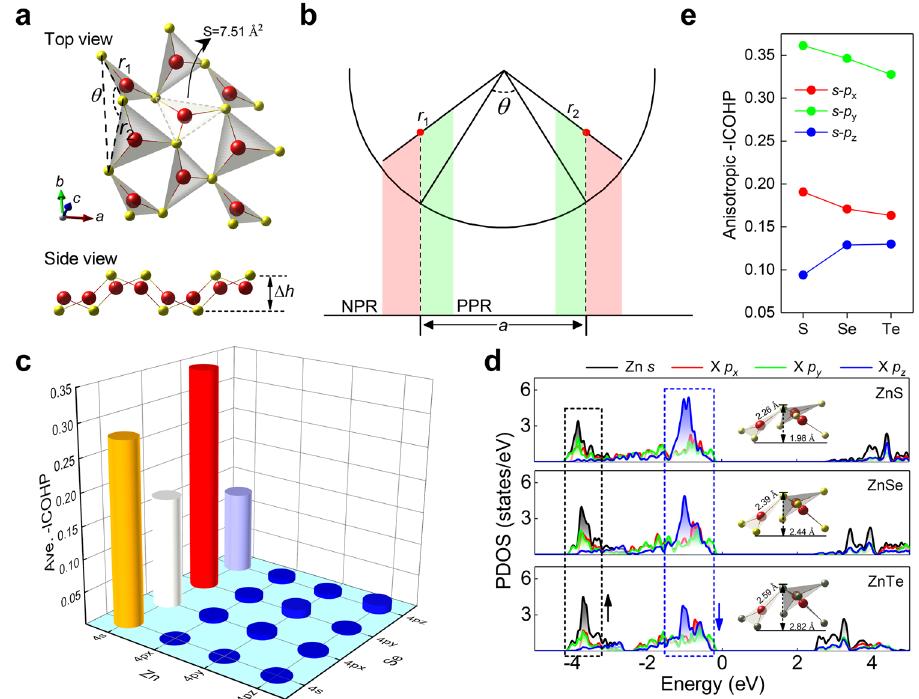
Fig. 5 Origin of the NPR for wz monolayers. a Top and side view for wz monolayer, in which we denote three structural parameters, i.e., the sides and angle of adjacently stacked triangles r 1 / r 2 and θ , and the layer height Δ h , here the symbol S denotes the area of the triangle. b Schematic representation for the occurrence of NPR in wz monolayer. c Average of the – ICOHP for all the possible atomic bonding pairs in ZnSe, which indicates the dominating role played by Zn s and Se p states in the orbital coupling. d PDOS for the ZnX with the inset showing the local structural deformation, which suggests the localized/dispersive Zn s /Se p z state. e Anisotropic bonding evolution for in-plane s - p x/y and out-of-plane s - p z orbital interactions in